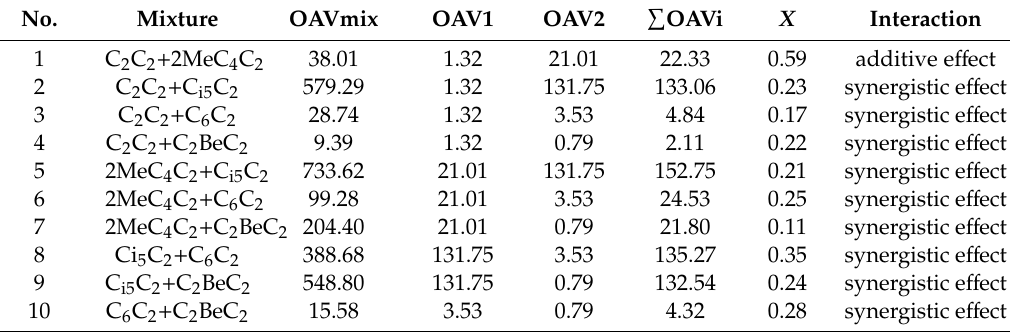
Table 5. The OAV approach to study the perceptual interaction between esters.